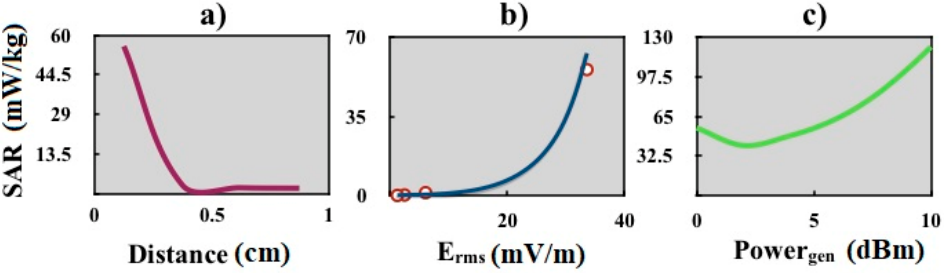
Figure 8. Averaged SAR as a function of distance ( a ), electric field ( b ), and applied power ( c ).